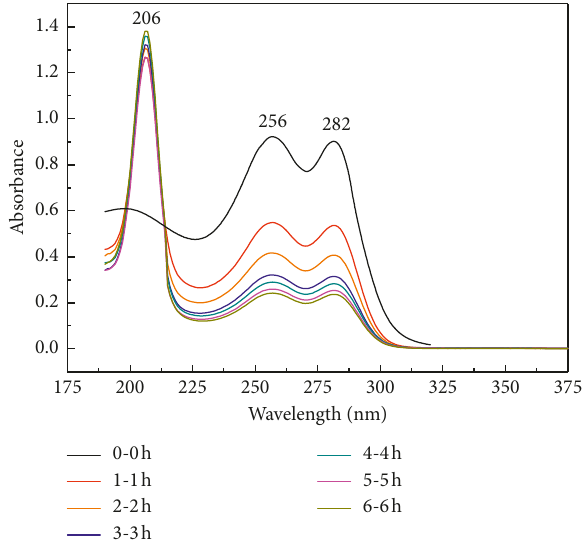
Figure 9: Influence of stewing time on the UV absorption spec- trum of reaction solution.